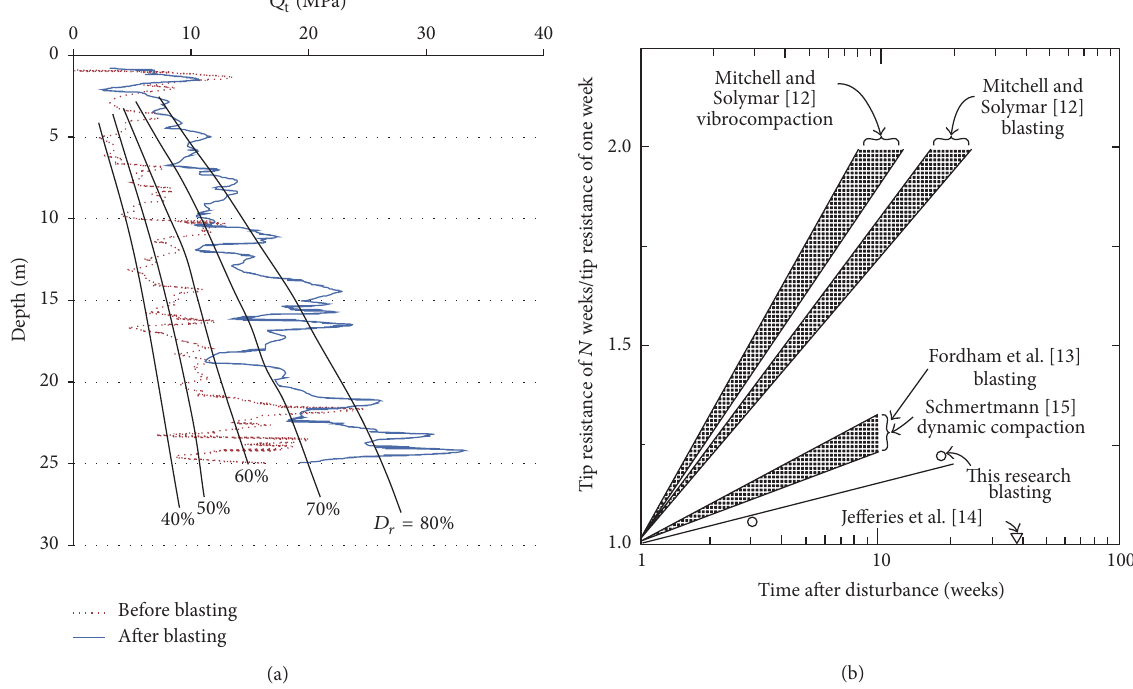
Figure 3: (a) The effect of EC on the increase of CPT cone resistance and relative density (CPT data from [9]). (b) CPT tip resistant increasing with time after (1) blast densification (Mitchell and Solymar [12], Fordham et al. [13], and Jefferies et al. [14]); (2) vibrocompaction (Mitchell and Solymar [12]); and (3) dynamic compaction (Schmertmann [15]). Research and comparison have been done by Charlie et al.